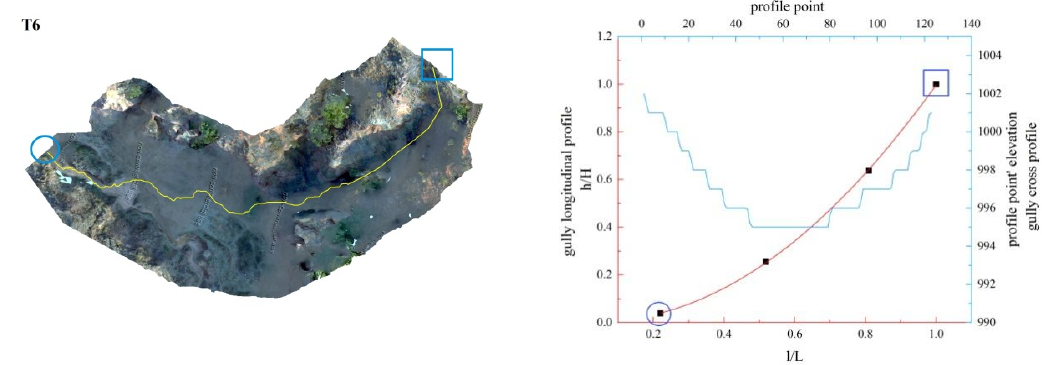
Figure 11. Gully shape and profile fitting diagram of T6.